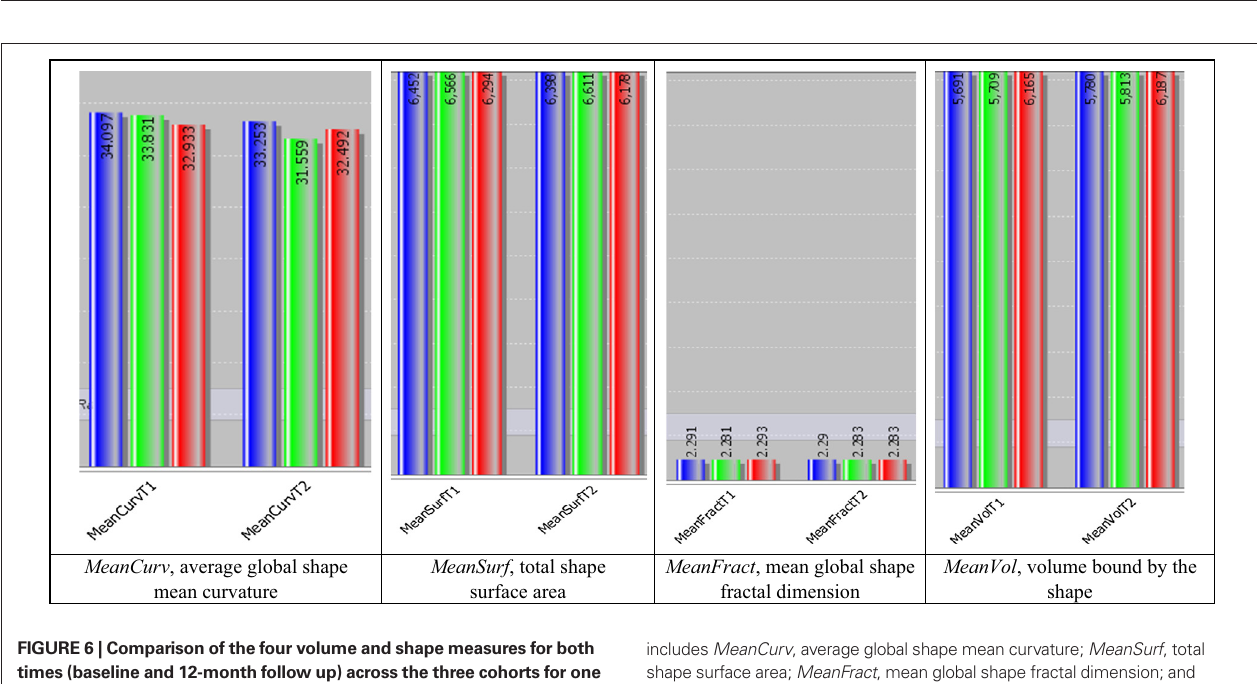
includes MeanCurv , average global shape mean curvature; MeanSurf , total shape surface area; MeanFract , mean global shape fractal dimension; and MeanVol , volume of the inside region of the shape. The three different cohorts, NC, MCI and AD, are colored in blue, green and red,